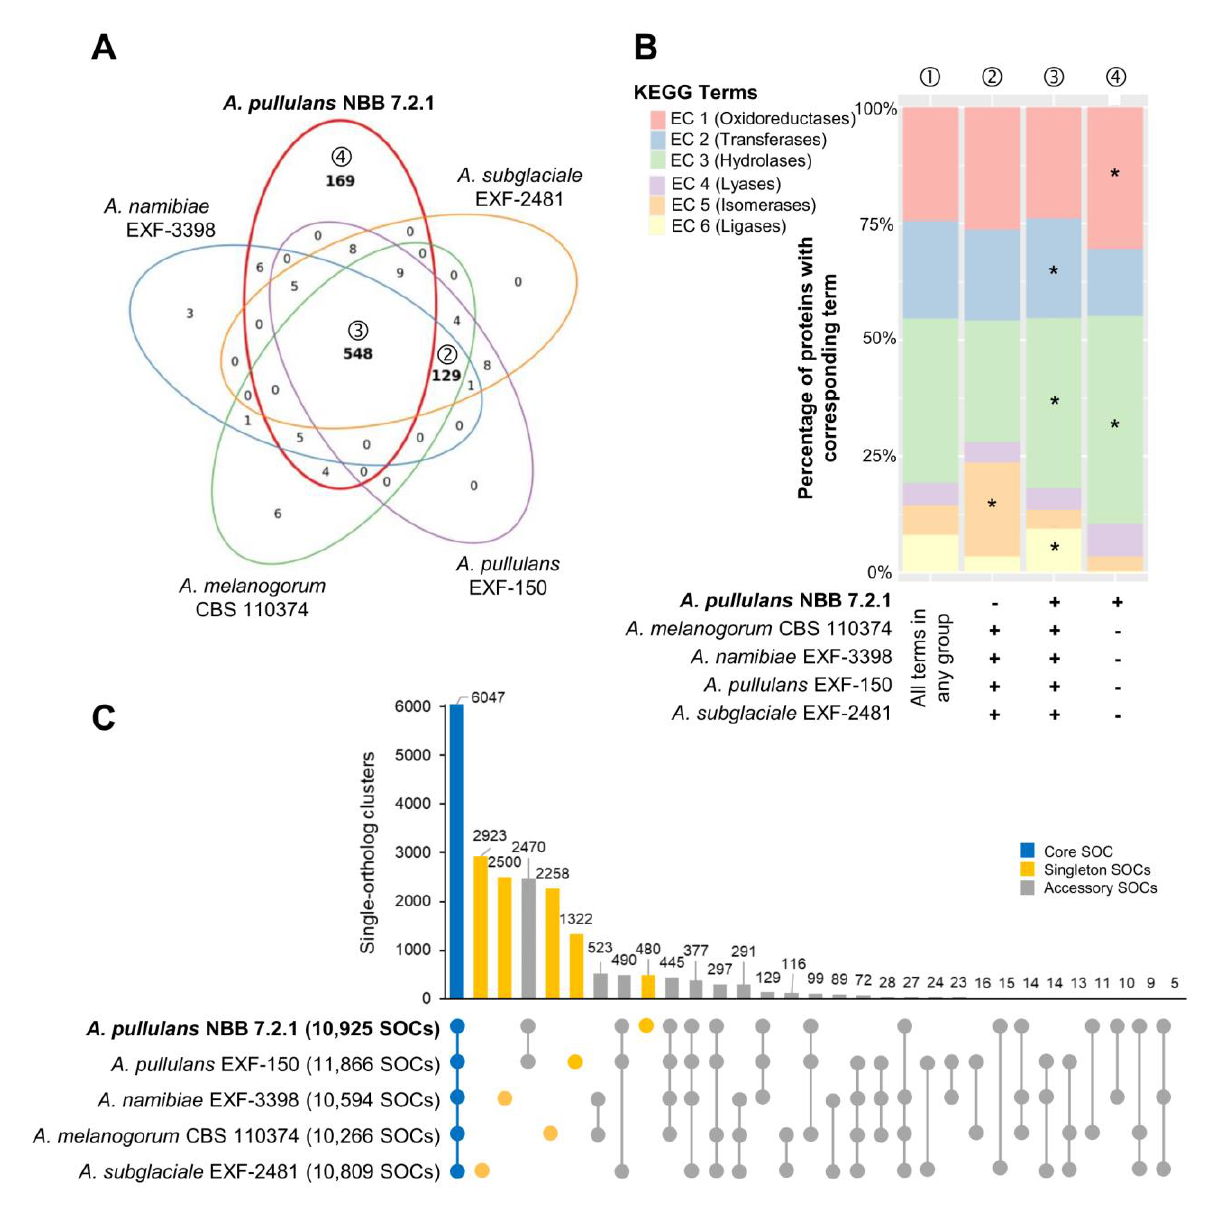
FIGURE 2 : Whole genome comparison of five Aureobasidium species. Gene annotations reveal that the A. pullulans NBB 7.2.1 genome contains more unique KEGG terms than the genomes of four other Aureobasidium strains. (A) KEGG term distribution among annotated genes of five Aureobasidium species. 548 terms were commonly found in all species, but a substantial number of terms (169) was unique for the A. pullulans NBB 7.2.1 genome or specifically lacking in this genome (129 terms; all bold). (B) The relative number of genes annotated to one of the six main enzyme classes (EC 1-6; oxidoreductases, transferases, hydrolases, lyases, isomerases, ligases) for all KEGG terms in the five Aureobasidium species and the subsets described in A. The enzyme classes highlighted with an asterisk (*) are significantly overrepre- sented (adj. p- value≤0.05) in the respective group (as compared to their frequency amon g all KEGG terms found in any of the five Aureo- basidium genomes (  )). Results are shown for those genes with terms shared among all genomes except A. pullulans NBB 7.2.1 (  ), shared among all five genomes (  ), or only present in A. pullulans NBB 7.2.1 (  ). (C) Pan-genome clustering of five Aureobasidium genomes visual- ized using an Up Set bar diagram [96]. The A. pullulans NBB 7.2.1 genome contained fewer (480) unique gene models than the four other Aureobasidium